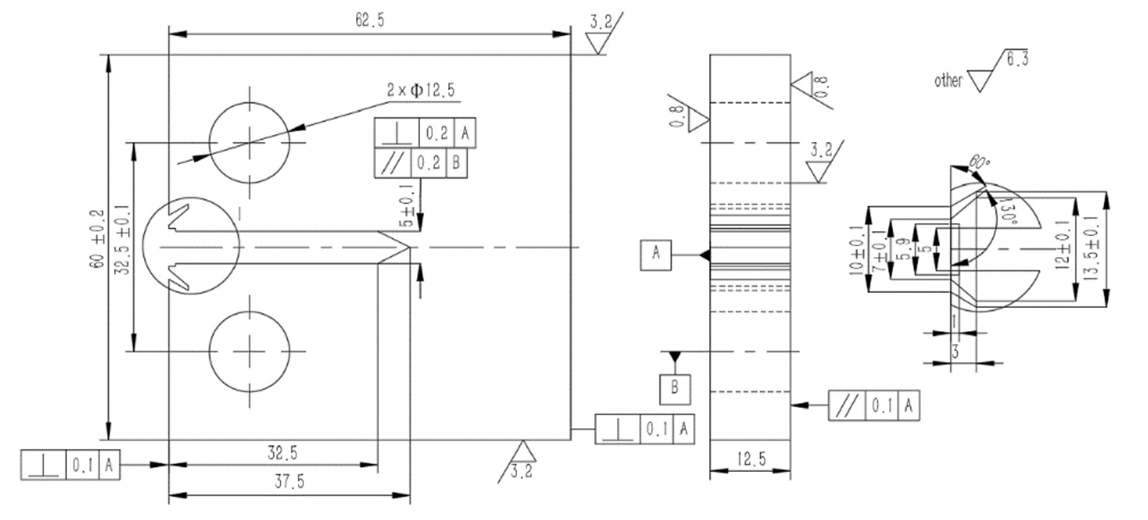
Figure 1. Sample size diagram. Table 1. Test scheme.